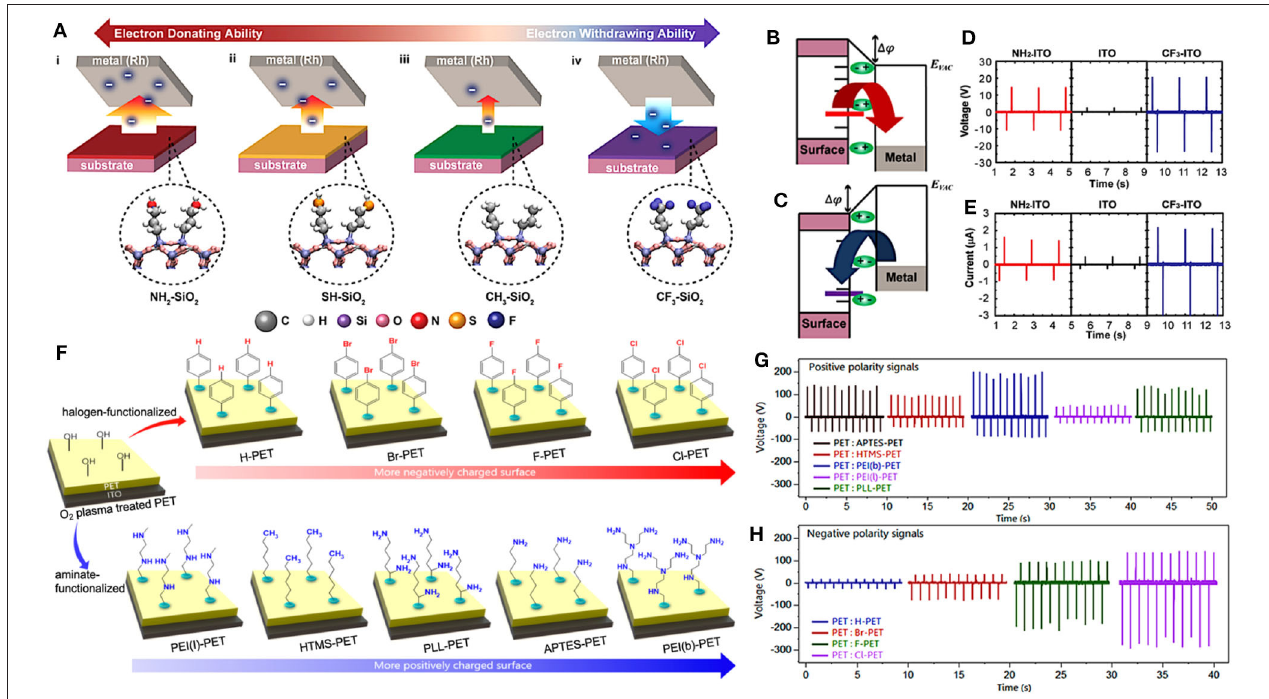
FIGURE 2 | Schematic representations of SAM-modified triboelectric materials and their output performance before and after functionalization. (A) Schematic diagram showing the propensity of the triboelectrification on (i) a strongly electron-donating layer (–NH 2 ), (ii) a moderate electron-donating layer (–SH), (iii) a neutral layer (–CH 3 ), and (iv) an electron-accepting layer (–CF 3 ). (B) Energy band diagrams of substrates modified with an electron-donating layer and (C) with an electron-accepting layer and that of the metal. (D) Open-circuit voltage and (E) short-circuit current of the triboelectric device composed of PI and SAM-modified ITO. Reprinted with permission from Byun et al. (2016). Copyright 2016 American Chemical Society. (F) Schematic illustrations of surface functionalized polyethylene terephthalate (PET) substrates with various halogen-containing and aminated molecules. (G) Output voltage generated by cyclic contacts between bare PET:aminated-PET pairs and (H) bare PET:halogenated-PET pairs. Reprinted with permission from Shin et al. (2017). Copyright 2017 American Chemical